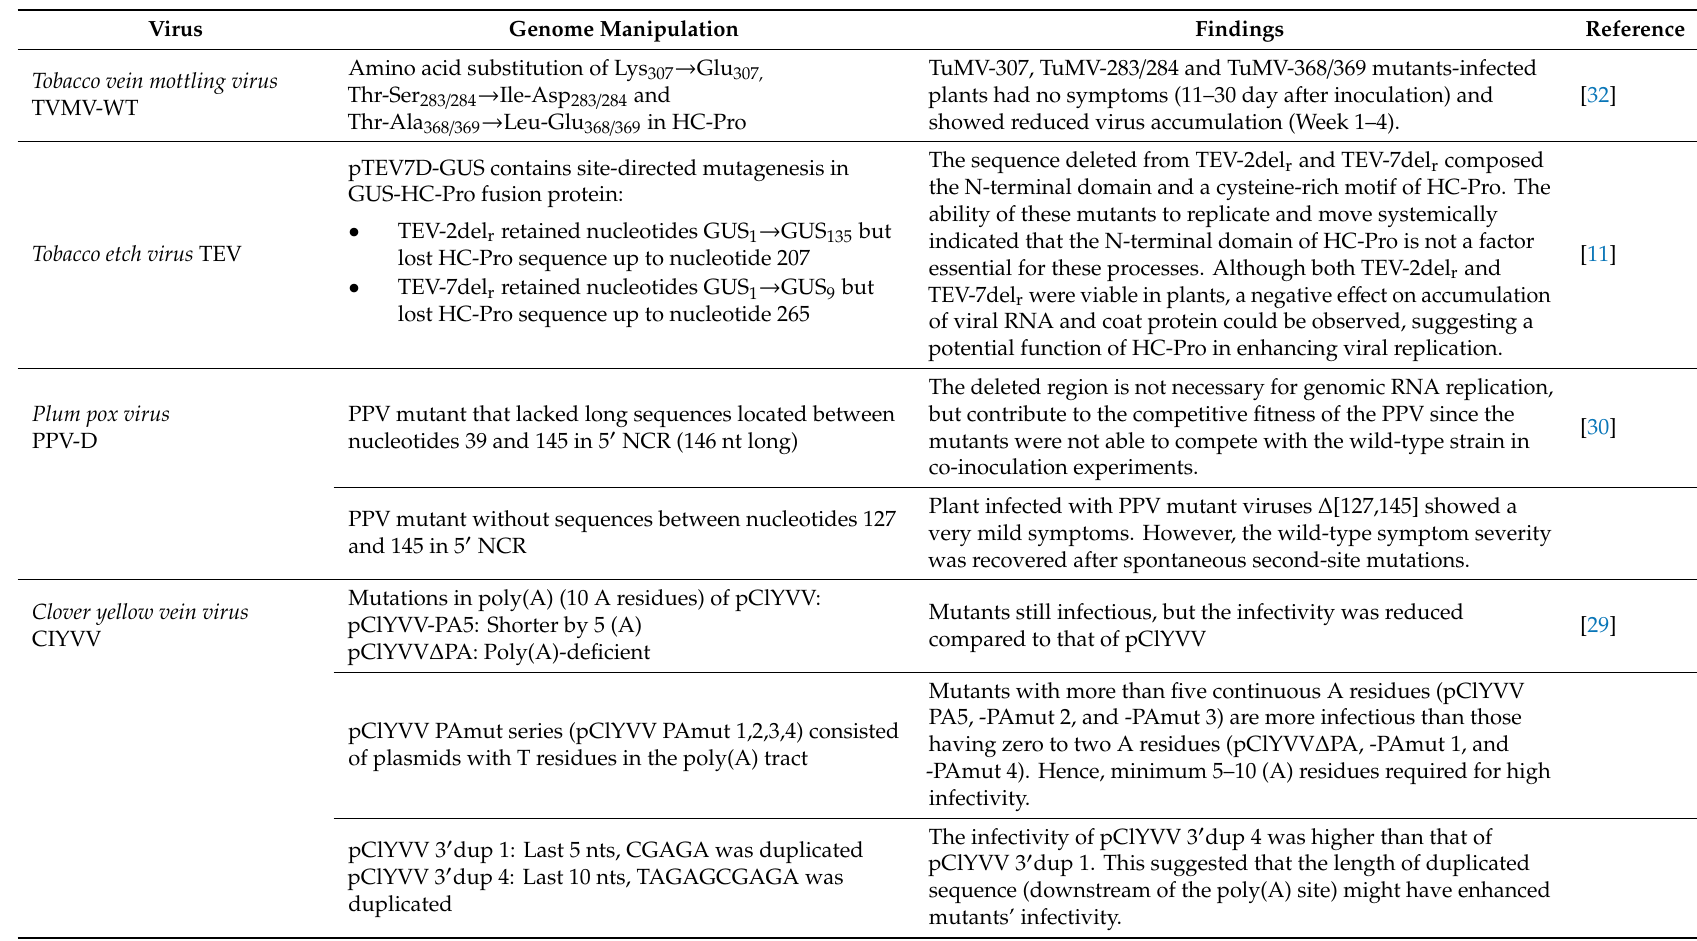
Table 1. Applications of reverse genetics techniques on biological properties related studies of